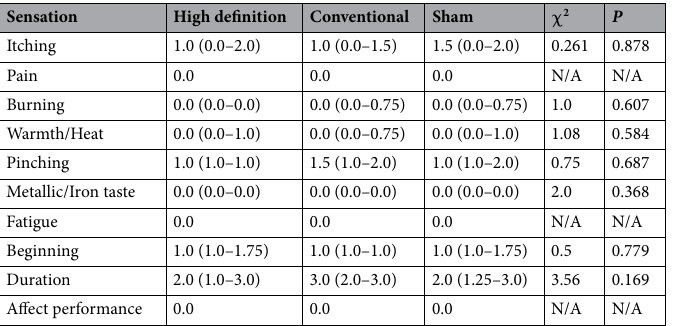
Table 2. Sensations felt by athletes during high-definition (HD), conventional, and active sham transcranial direct current stimulation (n = 12). Data described as median (interquartile range); N/A = not applicable.